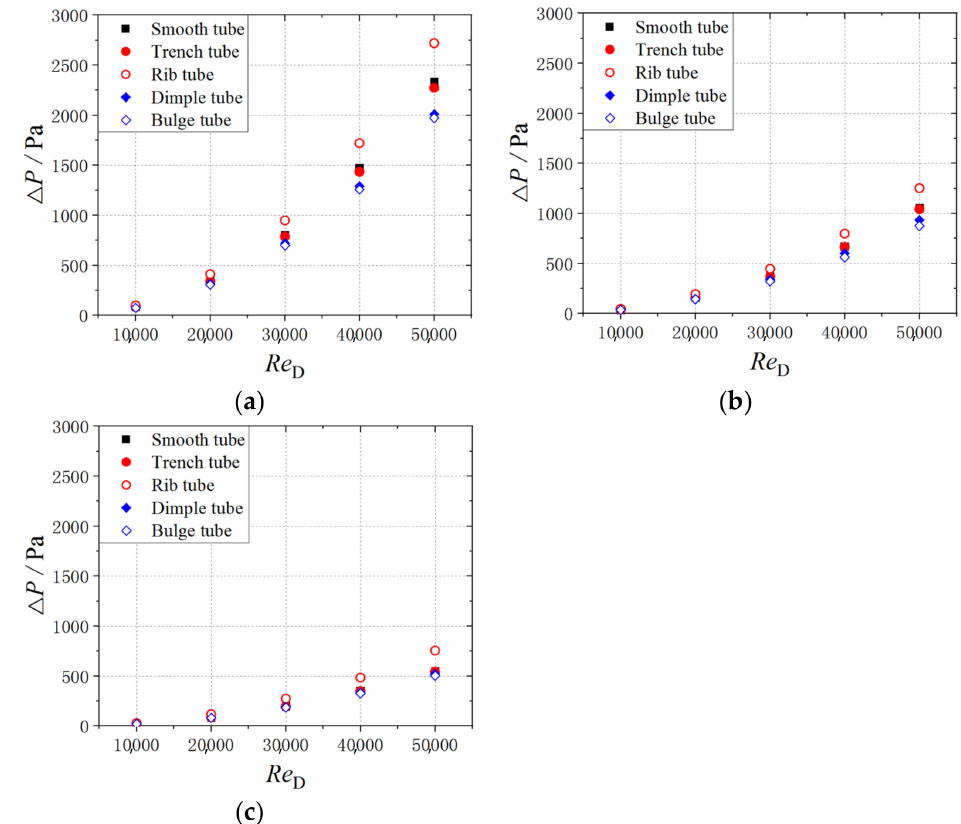
Figure 9. Comparisons of the pressure loss between the inlet and outlet with various surface structures at different Re D values: ( a ) three jets; ( b ) five jets; ( c ) nine